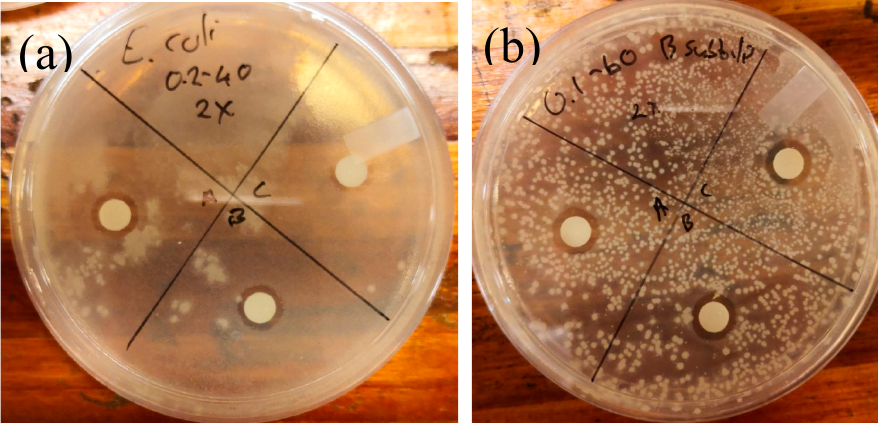
Figure 6. Photos showing disc diffusion test results: inhibition of ( a ) Escherichia coli and ( b ) Bacillus subtilis .